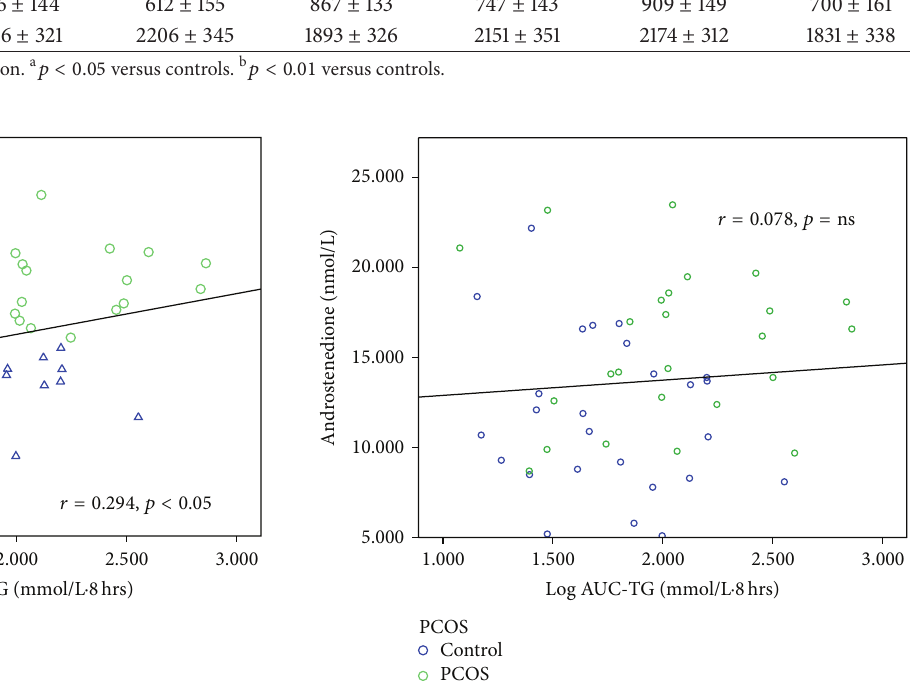
hypertriglyceridaemia, together with apoB and insulin sensi- tivity. AUC-TG was the only independent predictor of AUC- apoB-48, explaining 25.8% of the variance.